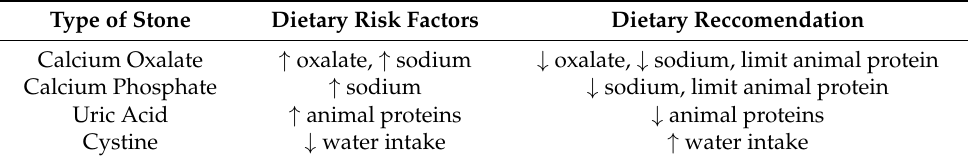
Table 2. Dietary risk factors and recommendations dependent on stone